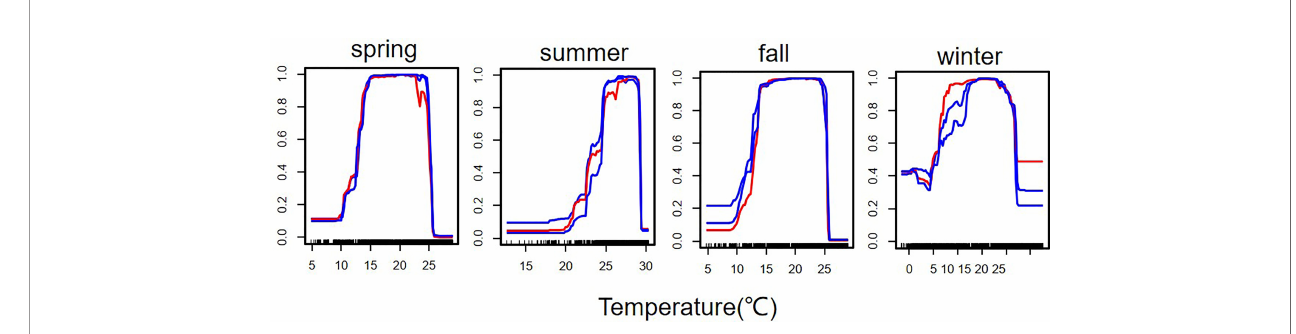
FIGURE 3 | Response of suitable habitat of Scomberomorus niphonius to temperature. Redlines represent the results of the second (middle) run of the response curve algorithm, and blue lines show the fi rst and third runs. Vertical lines represent temperatures on species